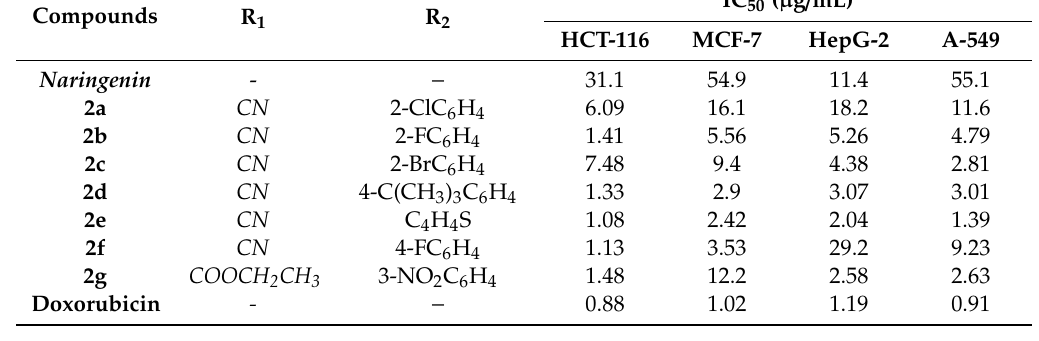
Table 7. Cytotoxicity of the chromene derivatives against the di ff erent cancer cell lines. Compounds